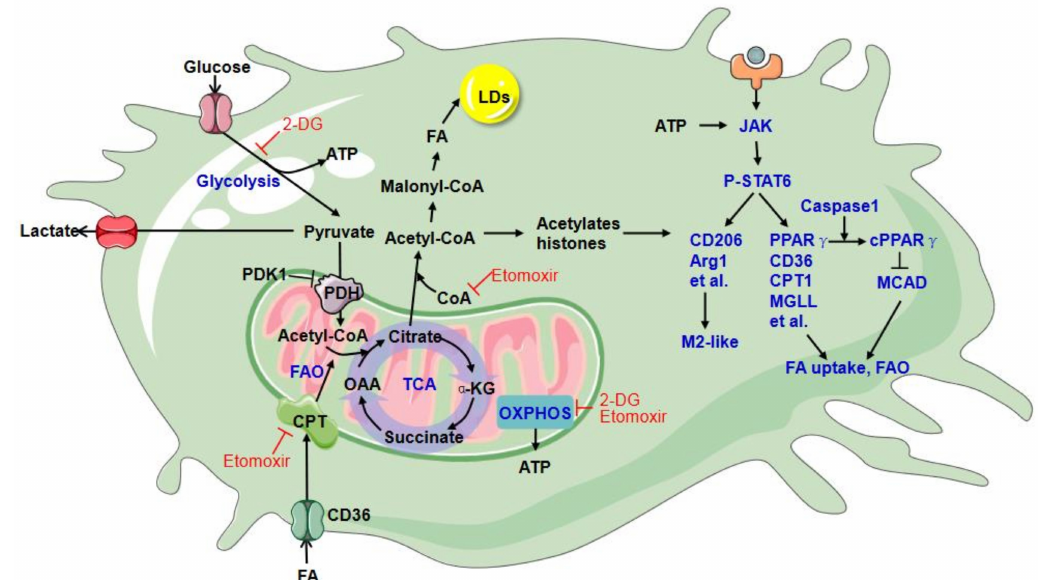
Figure 2. Glucose and lipid metabolism in TAMs. TAMs exhibit a pronounced glycolytic signature enhanced lipid uptake and accumulation. Glucose-derived pyruvate is partly converted to acetyl-CoA by the PDH complex to fuel the TCA cycle, supporting OXPHOS. ATP, from both glycolysis and OXPHOS, can be used to activate the JAK–STAT6 pathway in M2-like activation. 2-DG inhibits TAM phenotype and function due to impaired OXPHOS in addition to glycolysis. Activation of the JAK–STAT6 pathway induces gene expression related to FAO and FA uptake. The caspase1-mediated cleavage of PPAR γ attenuates MCAD activity, and FAO promotes LD formation. The elevated level of the scavenger receptor CD36 plays a crucial role in lipid uptake and accumulation in TAMs. The LD formation is essential for TAMs as a stable source of fatty acids for fatty acid oxidation (FAO). Acetyl-CoA converted from citrate feeds FA synthesis and acetylates histones to regulate TAM gene expression. Etomoxir, an inhibitor of CPT1, inhibits FAO and inhibits complex I of the electron transport chain and depletes CoA, eventually impairing M2 activation and the protumor growth activity of TAMs. 2-DG: 2-deoxyglucose; α KG: α -ketoglutarate; CoA: coenzyme A; CPT: carnitine palmitoyltransferase; FA: fatty acid; LD: lipid droplet; MCAD: medium-chain acyl-CoA dehydrogenase; MGLL: monoacylglycerol lipase; OAA: oxaloacetate; OXPHOS: oxidative phosphorylation; PDH: pyruvate dehydrogenase; PDK1: pyruvate dehydrogenase kinase 1; TAMs: tumor-associated macrophages; TCA: tricarboxylic